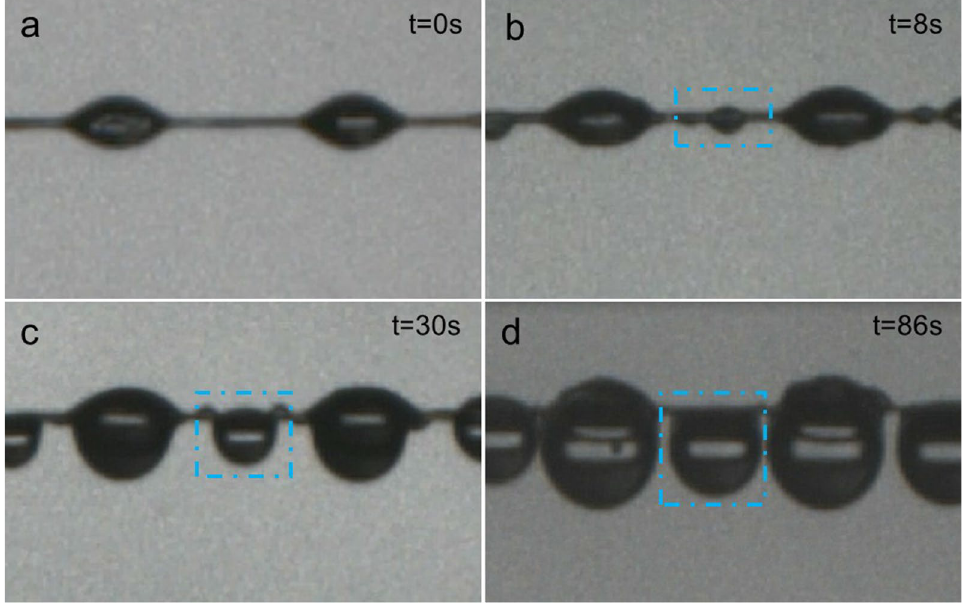
Fig. 6 Digital photos showed the formation of middle drops at different time of pionts ( a 0 s; b 8 s; c 30 s; d 86